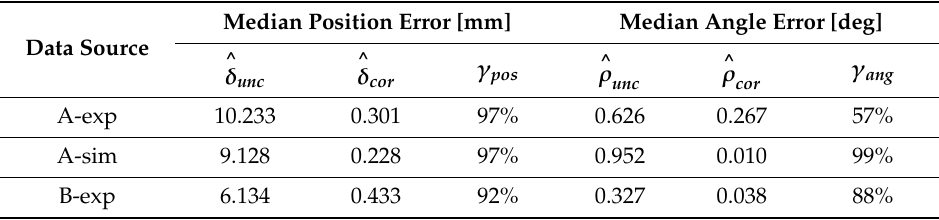
Table 1. Median robot